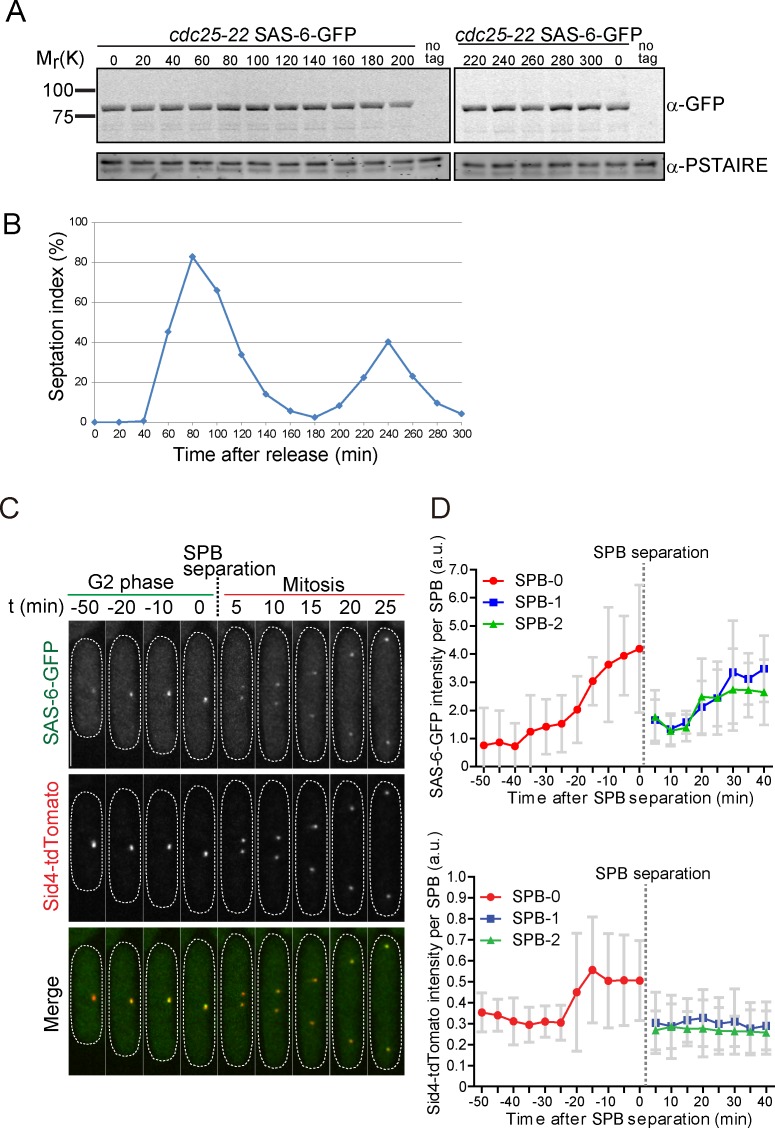
Localization of SAS-6 at the fission yeast SPB is cell-cycle regulated.(A) The fission yeast strain with cdc25-22 mutation expressing SAS-6-GFP under the atb2 promoter was blocked in the G2/M boundary and synchronously released into mitosis. Cells were collected every 20 min and protein extract was prepared. Protein expression was analyzed by western blotting with anti-GFP and anti-Cdc2 PSTAIRE (loading control). (B) Septation index was determined to check the cell cycle synchronization. Note that cell cycle progression was highly synchronized. (C) SAS-6 localization along the cell cycle. Representative micrographs of time-lapse imaging of cells expressing SAS-6-GFP and Sid4-tdTomato from G2 phase to the end of mitosis. Scale bar, 5 μm. (D) Quantification of the intensity of SAS-6-GFP and Sid4-tdTomato per SPB in the cells shown in C. Mean SAS-6-GFP (top) and Sid4-tdTomato (down) intensity per SPB ±s.d before and after the SPB separation is shown (N = 7). SPB-0, unseparated SPB and SPB-1 and 2, separated SPBs.10.7554/eLife.41418.015Figure 4—figure supplement 3—source data 1.The source data to plot the graphs in Figure 4—figure supplement 3B and E.